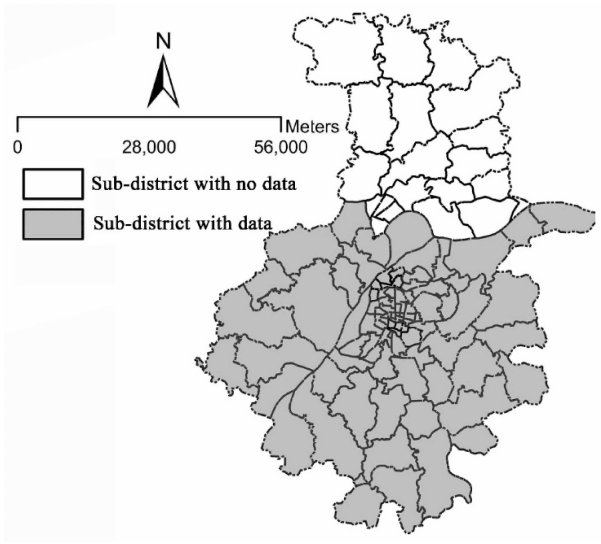
Figure 1. Map of Nanjing in